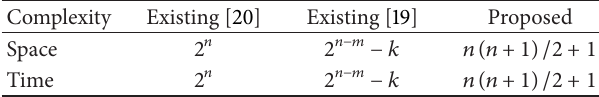
Table 3: Complexities of the existing and the proposed